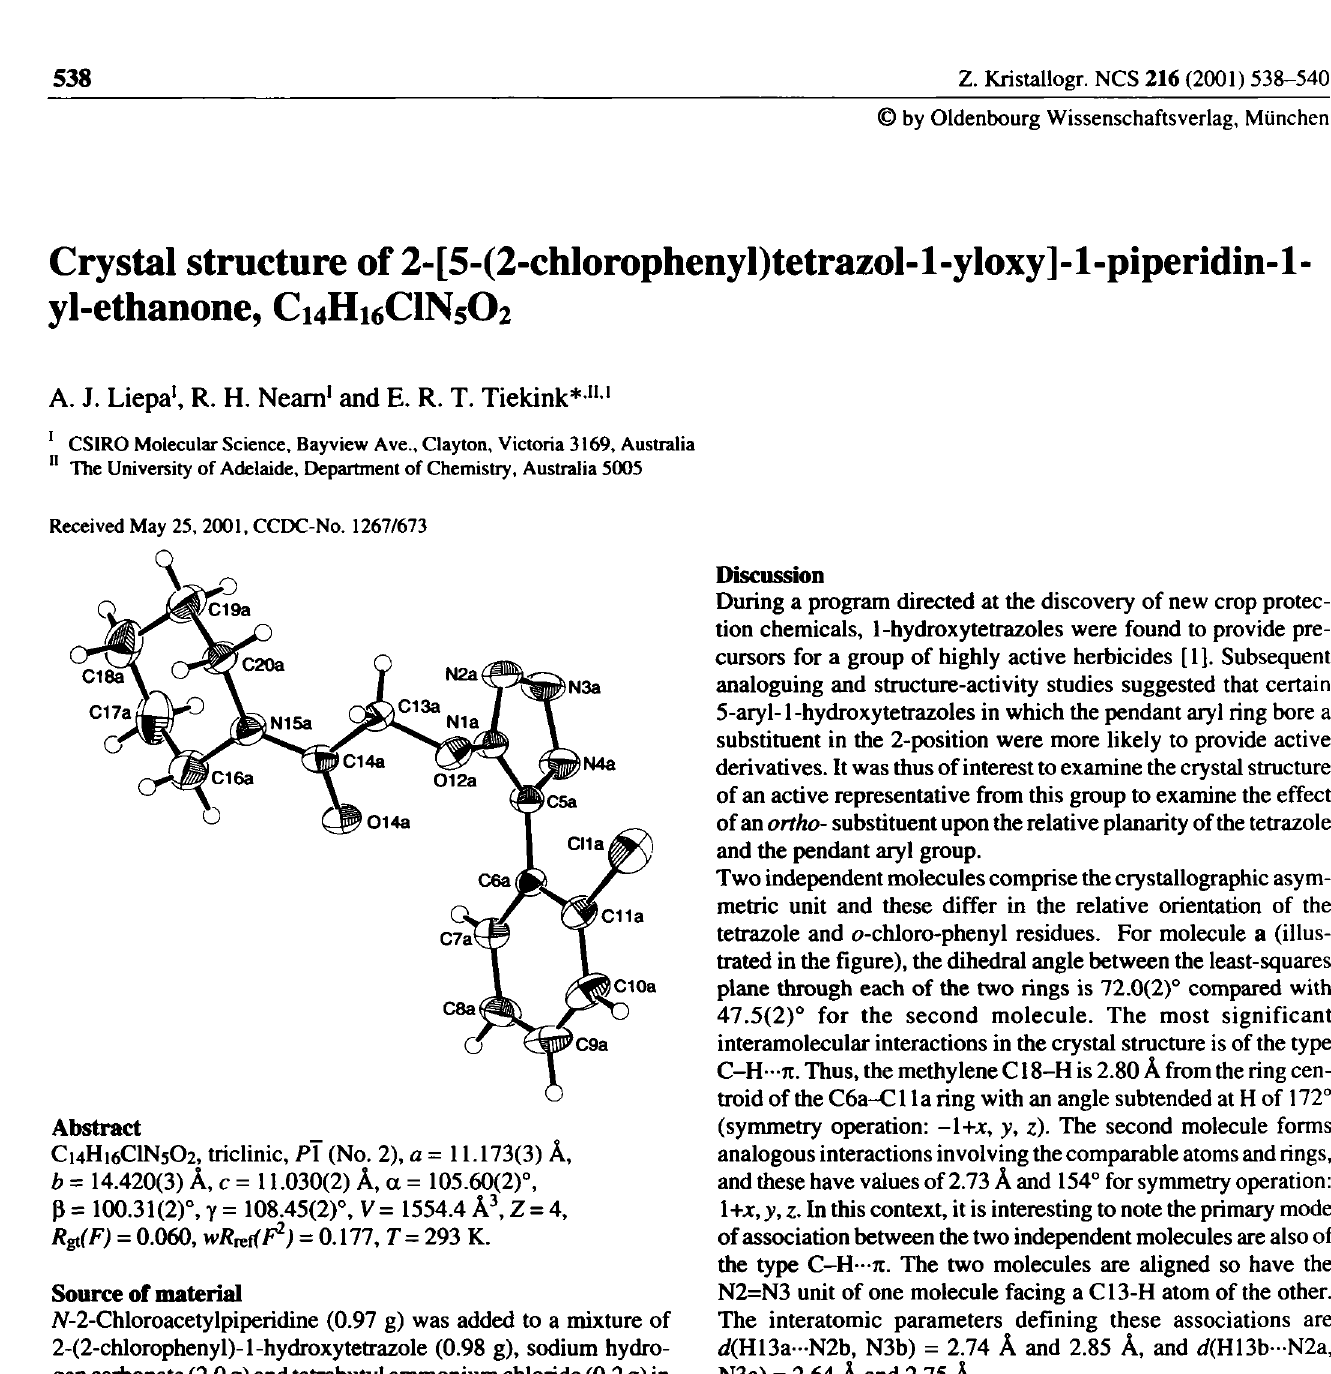
Table 1. Data collection and handling.